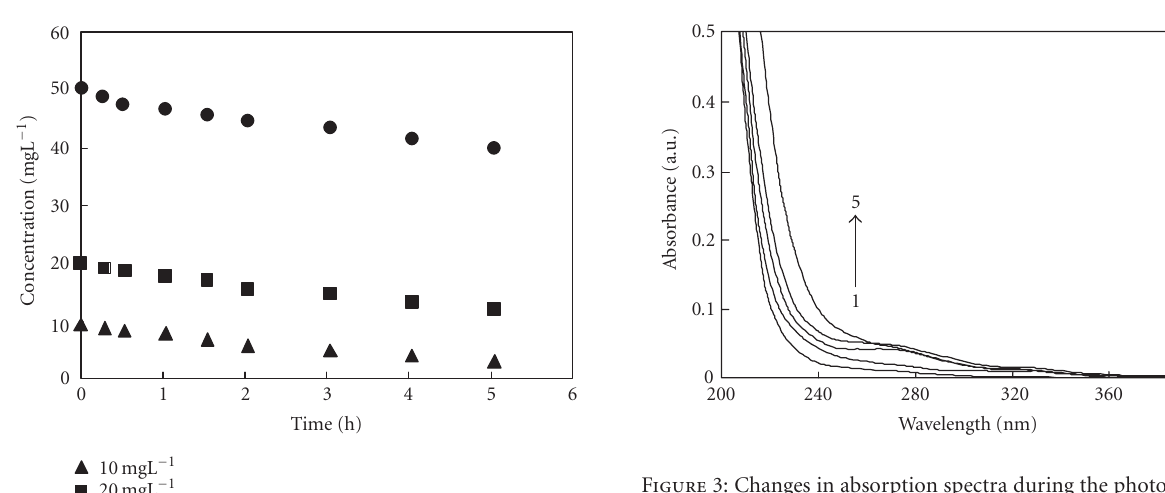
Figure 3: Changes in absorption spectra during the photocatalytic degradation of a 50mg L − 1 aqueous solution of lincomycin: spectra 1–5 denote irradiation for 0, 30, 90, 120, and 300 min, respectively.